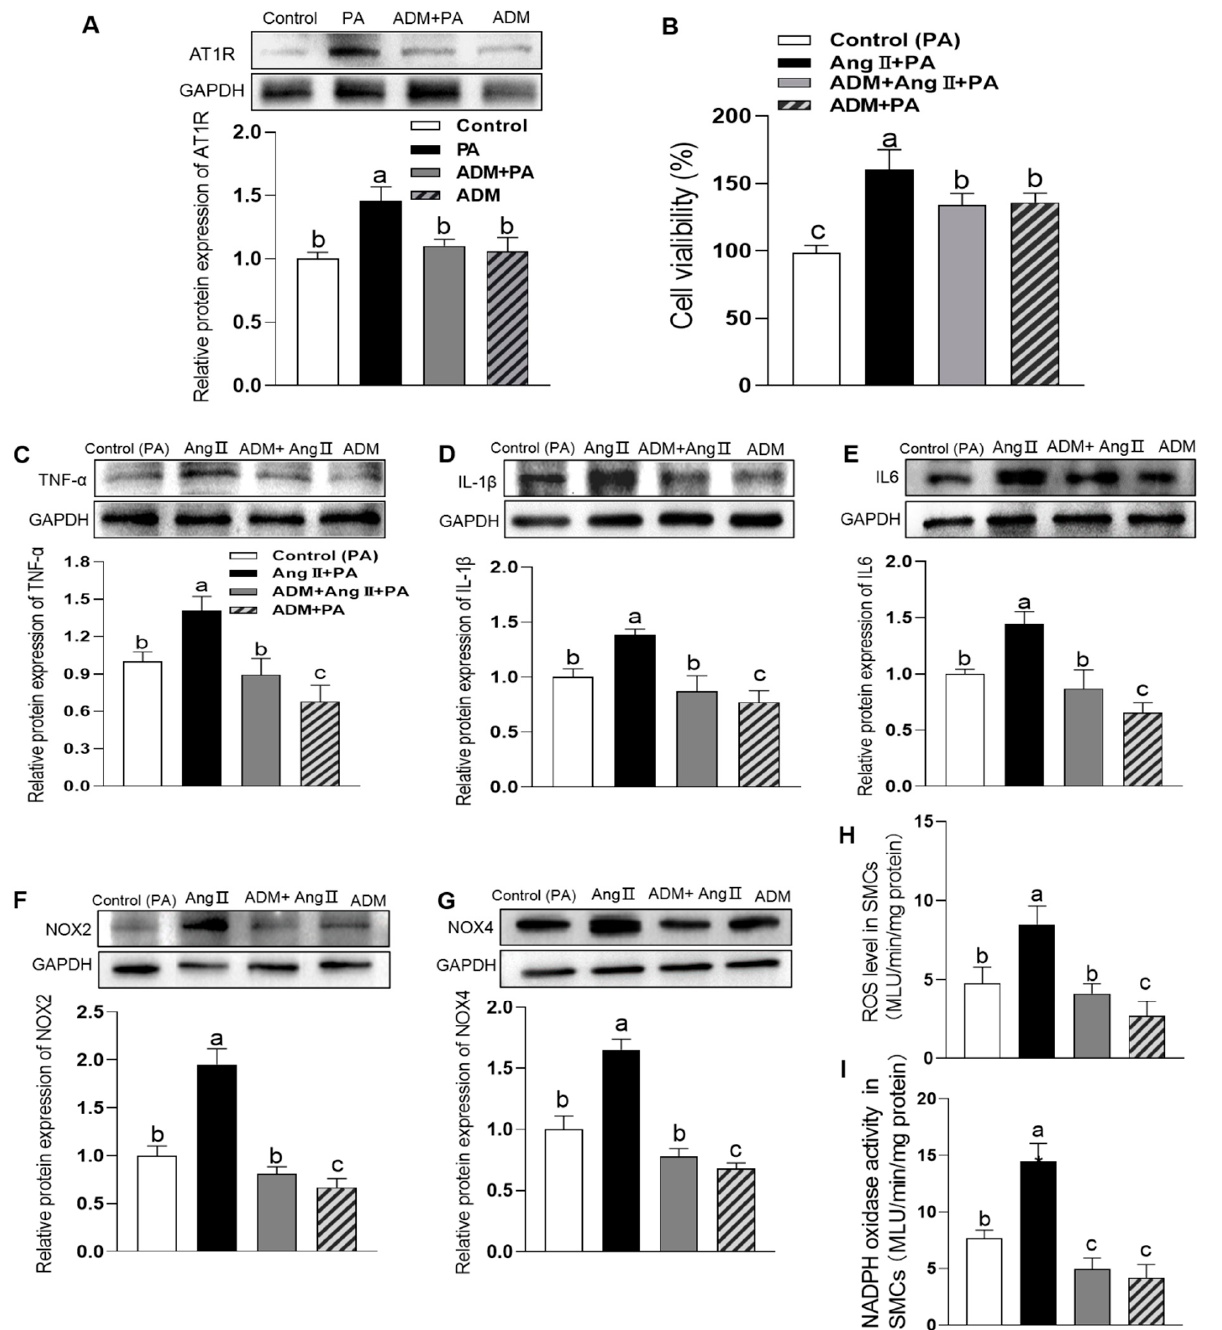
Figure 5 . The effects of ADM (10 nM) on AT1R expression in A7r5 cells-treated by PA (200 μ M, ( B )), and on the combination of PA plus Ang II-stimulated cell viability ( A ), inflammation ( C – E ) and oxidative stress ( F – I ) in A7r5 cells. The protein expression levels of proinflammatory cytokines TNF- α ( C ), IL-1 β ( D ) and IL6 ( E ) were measured to reflect inflammation state and the NOX2 and NOX4 protein expression levels ( F , G ), ROS level ( H ) and NADPH oxidase activity (I) were detected to reflect oxidative stress state. ADM was administrated in A7r5 cells for 30 min, then cells were exposed to PA plus Ang II (10 nM) for further 24 h. Each value indicates mean ± SEM. n = 3 to 6. Values with the same superscript letter are not significantly different and the different letters indicate significant differences between the groups ( p < 0.05, one-way ANOVA followed by Bonferroni post hoc analysis).